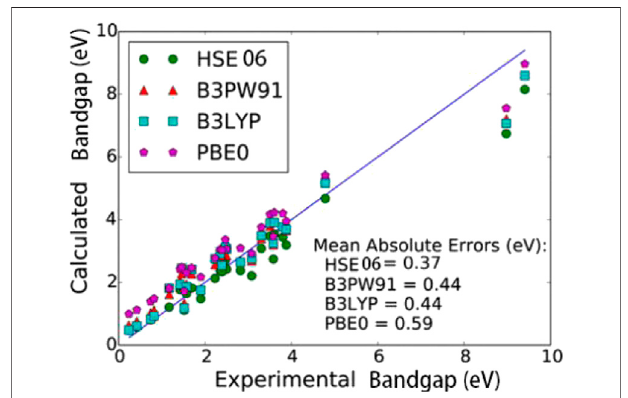
FIGURE 13 | Calculated vs experimental bandgaps for various compounds using DFT functionals. B3LYP and B3PW91 give extremely similar bandgaps. This is most likely due to the incorporation of similar amounts of HF exchange, B3LYP and B3PW91 both have 20% full- range nonlocal exchange, while HSE06 includes 25% but only in the short- range, PBE0 includes 25% full-range HF exact exchange, which leads to an overestimation of the